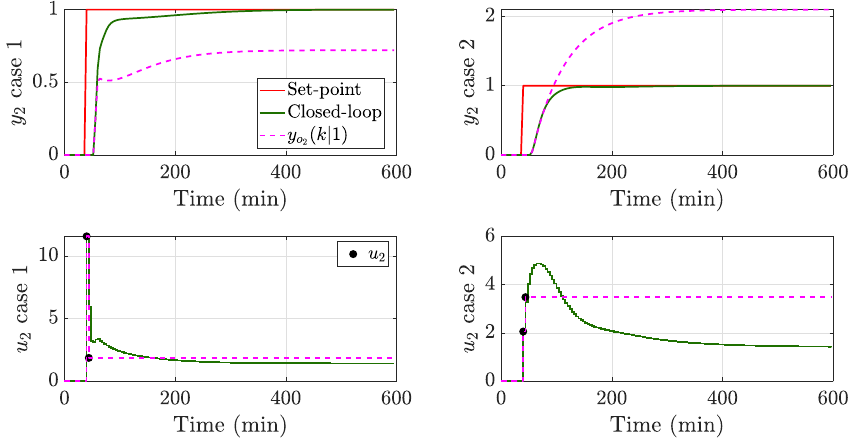
Figure 7. Determination of the prediction and control horizons of the HOF output y 2 and input u 2 .